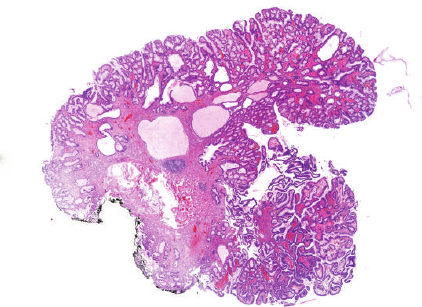
Figure 15: Numerous IgG4-positive plasma cells in colonic tra- ditional serrated adenoma (immunohistochemistry IgG4, original magnification